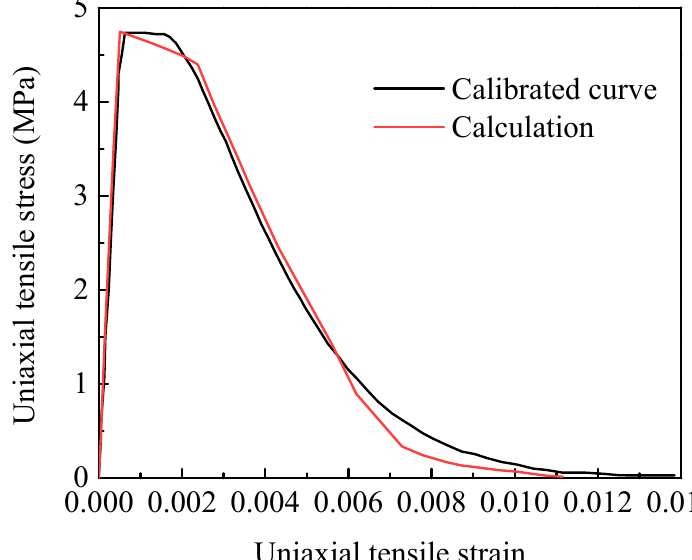
Figure 4. Calculated and measured stress-strain curves for HMX under uniaxial tension loading at strain rate of 10 − 3 s − 1 . Calibrated curve is due to Wu et al. [24].